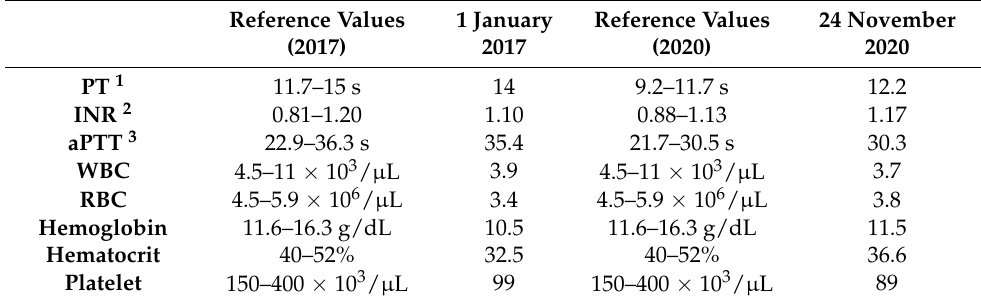
Table 1. Significant laboratory values from the 2017 and 2020 hospital